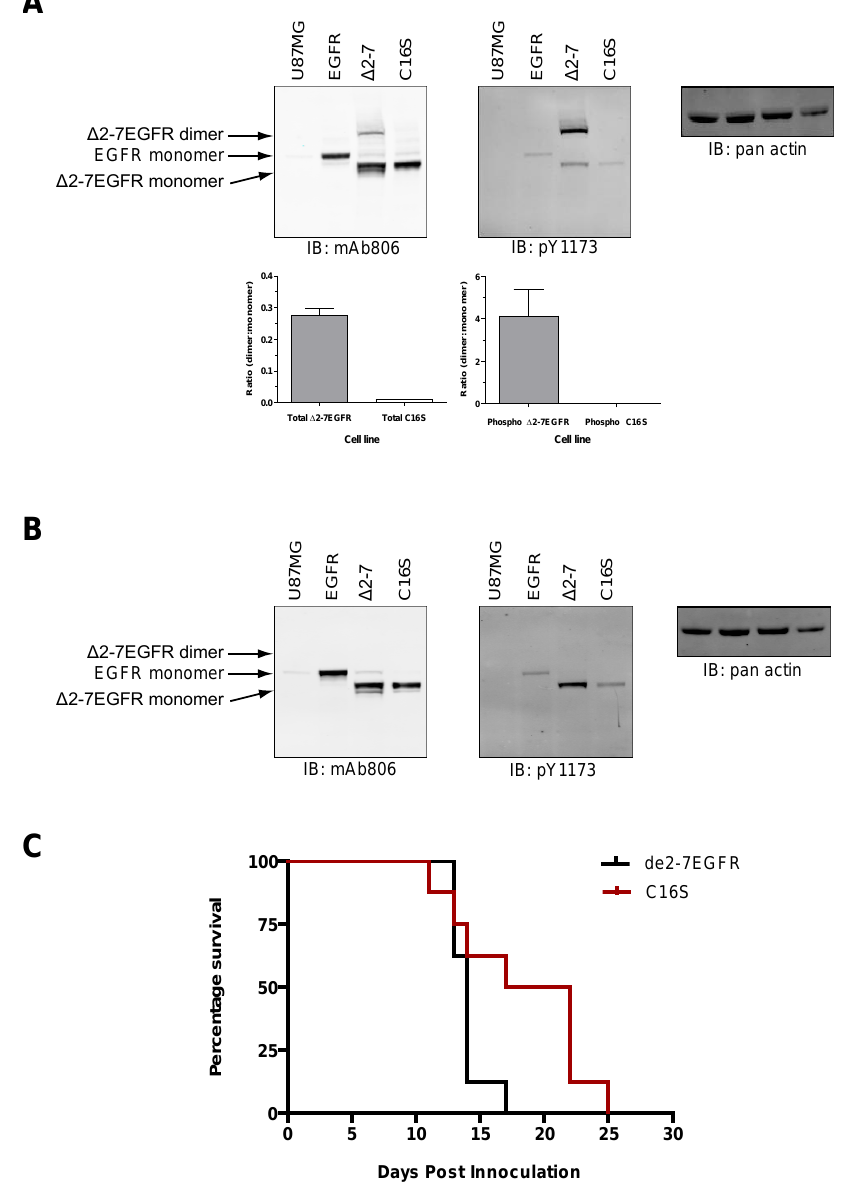
Figure 7. de2-7EGFR forms reduction-sensitive homodimers in vitro through its free cysteine residue. Cells were lysed and equal protein probed by Western blot under non-reducing ( A ) and reducing ( B ) conditions for total EGFR/de2-7EGFR by mAb806 blotting ( left hand panels ) and pY1173 ( middle panels ). A pan actin blot was used as the loading control ( right hand panels ). Graphed data of dimer:monomer densitometry ratios ± S.E. for non-reducing mAb806 ( lower left graph ) and pY1173 ( lower right graph ) are depicted under each blot in ( A ). U87MG parental cells (U87MG) and U87MG overexpressing the wtEGFR (EGFR) were included as control for the wtEGFR on the blots. In all cases representative results from multiple repeats are shown ( C ) C16S is less tumorigenic than unmodified de2-7EGFR. Nude mice were injected subcutaneously into both flanks with transgenic U87MG cells expressing either unmodified de2-7EGFR or the C16S variant. Kaplan-Meier survival curves were then determined based on a tumor volume of 1000 mm 3